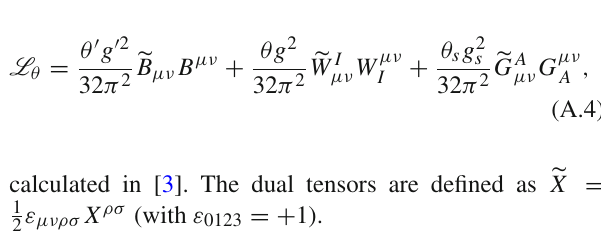
Table 3 Purely fermionic operators which preserve Baryon number